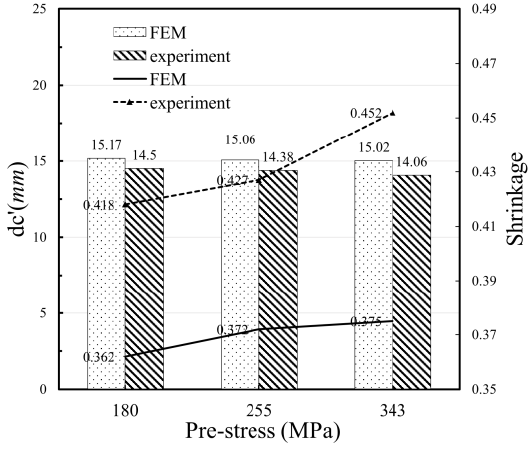
Figure 29. Shrinkage rate of the fracture section in the simulation and test.